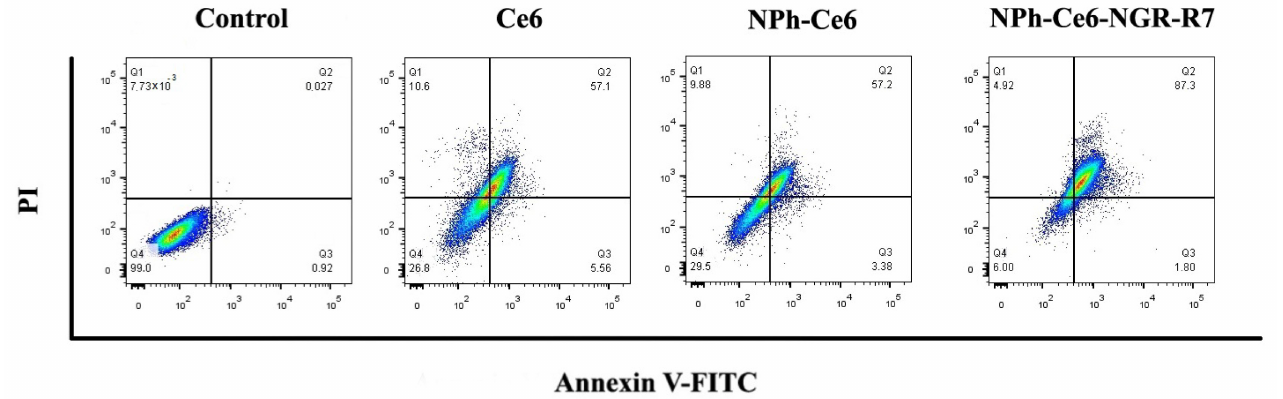
Figure 2. Analysis of apoptosis in HT-1080 cell culture after PDT (e6 chlorine concentration 2.0 mcg/mL, irradiation dose 1 J/cm 2 ) for cells incubated with free Ce6; phospholipid composi- tion NPh-Ce6; phospholipid composition with peptides NPh-Ce6-NGR-R7. Quadrant design: top left (Q1)—necrosis, cells stained with PI; top right (Q2)—late apoptosis; cells stained with PI and Annexin V simultaneously; bottom right (Q3): early apoptosis, cells stained with Annexin V; bottom left (Q4)—fluorescent signal at the level of autofluorescence of unstained